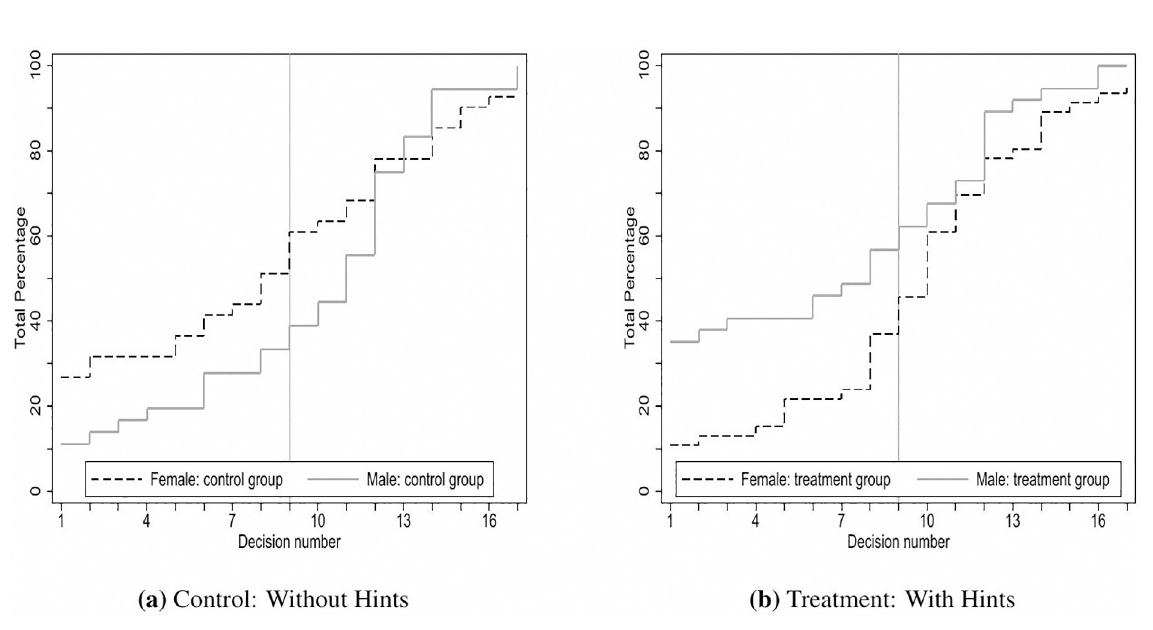
Fig 5. Cumulative switching point from option A to